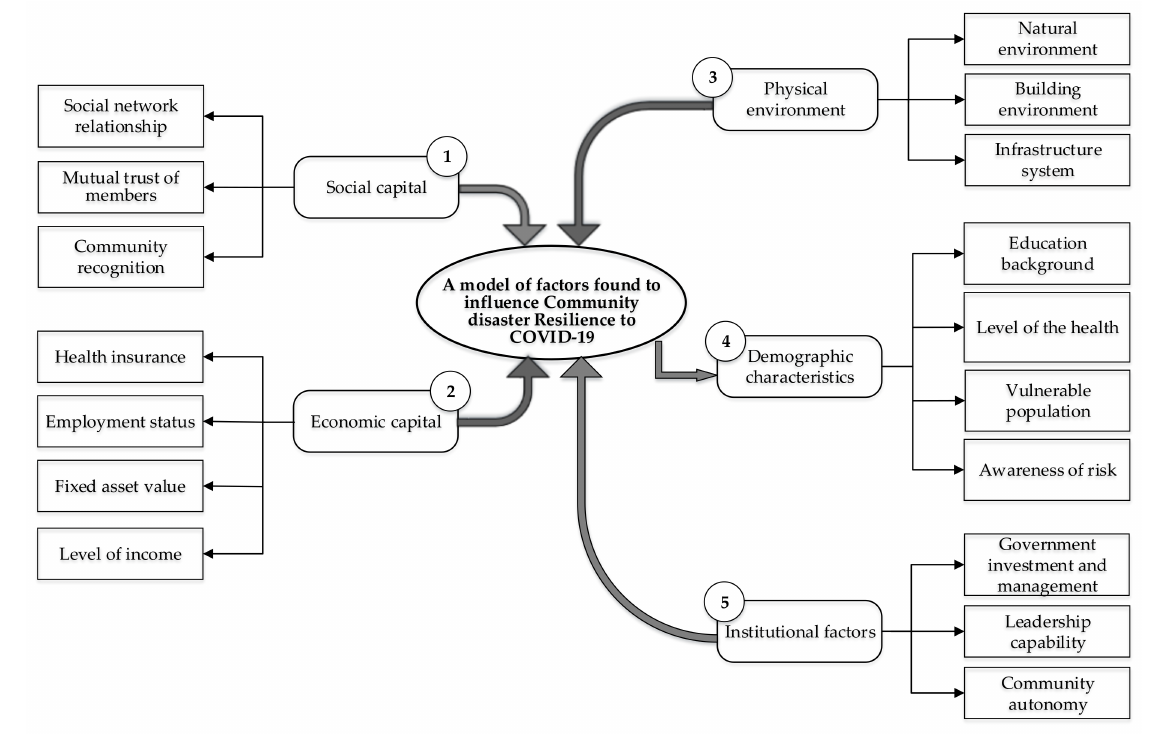
Figure 3. A model of factors found to influence community disaster resilience to